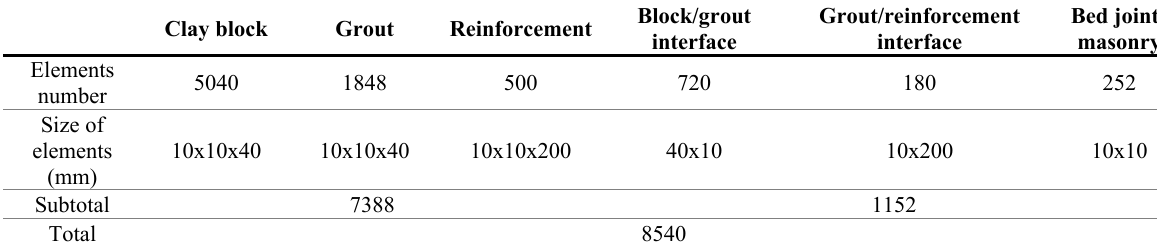
Table 6. Number and size elements of the pull-out